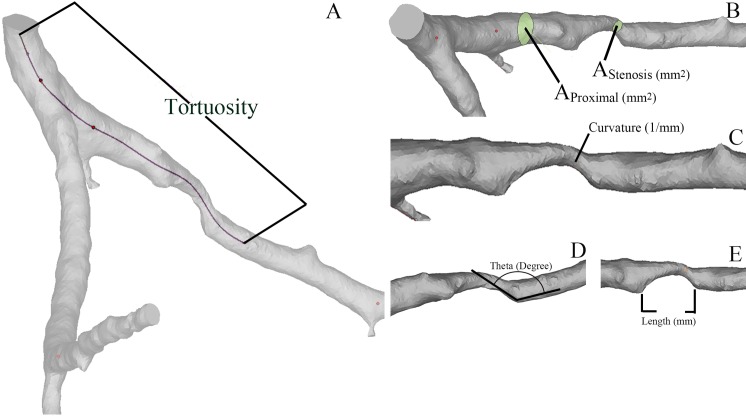
The geometric characteristics include severity of stenosis, tortuosity of the lesion segment, curvature of the lesion segment, angle of the lesion and length of the lesion.A: Tortuosity (T) was taken as the ratio of the length from the ostium of the coronary segment to 1 cm distal to the stenosis (L) to the distance between the ends of the segment (C). B: The severity of the stenosis is the ratio of the cross-section area in the remain lumen at the stenosis and the healthy proximal segment. C: Curvature (unit: 1/m) of the stenotic artery segment was measured, of which the ends of the segment were 1cm proximal to the stenosis and 1cm distal to the stenosis. D: The angle of the lesion was measured at the immediate distal edge of the lesion (unit: degree). E: The length of the lesion was also measured (unit: mm).